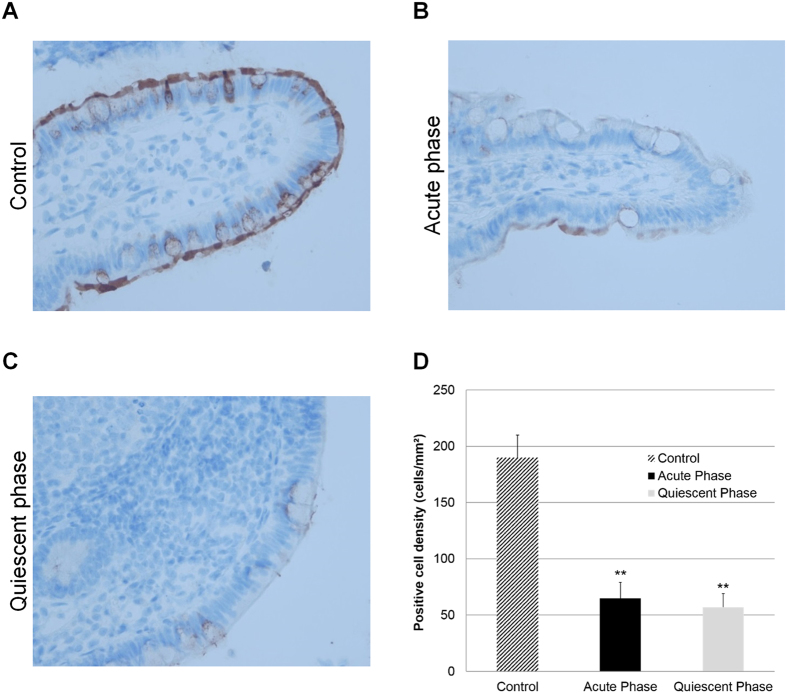
GPR43 expression in the intestinal biopsies of patients with CD and controls.(A) GPR43 immunohistochemical staining of TMA from ileum biopsies of controls, (B) patients in the acute inflamed phase and (C) patients in the quiescent phase of CD. Each spot shows representative tissue immunostaining for GPR43 and for secondary antibody alone (A–C, immunoperoxidase, original magnification ×400). Quantification of GRP43 immunostaining using the Spot Browser software in TMA from ileum biopsies of controls and patients in the acute or quiescent phase of CD, **P < 0.001.